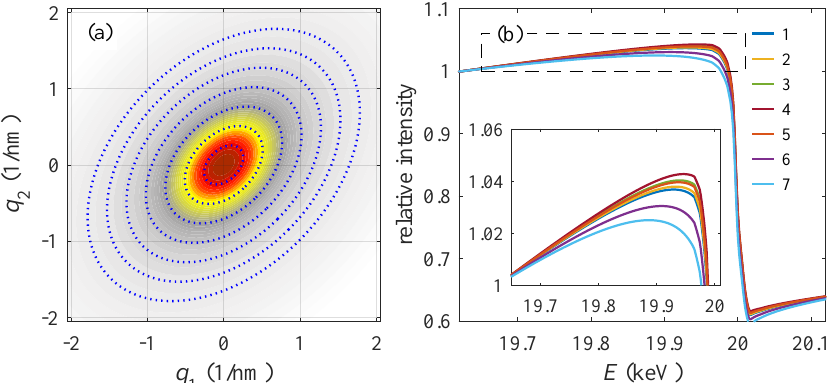
Figure 5. ( a ) Simulated diffraction maximum ( 44¯82 ) ω , mean particle radii R V = 6 nm and R L = 4 nm, the intensity is plotted in logarithmic scale, the colors from white to dark red span over 4 decades. The elliptical ROIs are displayed by blue dotted lines. ( b ) The AXRD spectra of individual ROIs (parameters of the curves) from ( a ). The first ROI is inside the smallest ellipse, while the last ROI is between the largest and second largest ellipses. The dashed rectangular region is enlarged in the inset. The AXRD intensities are normalized to their values at 19.6 keV, see the main text for